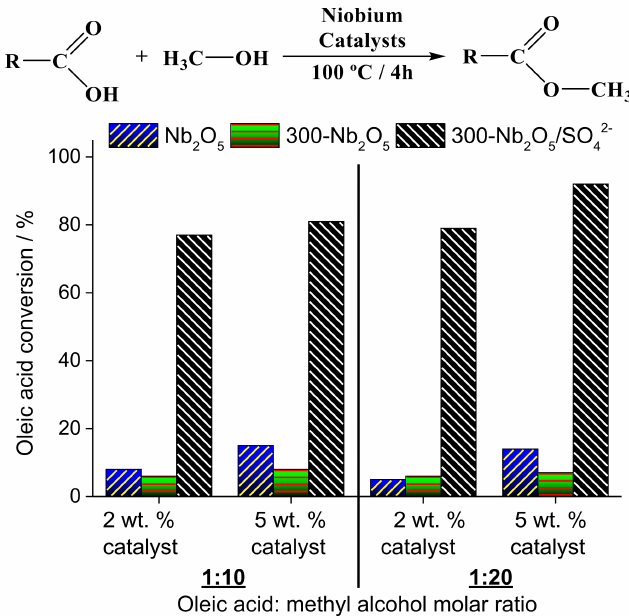
Figure 11. Esterification reaction of oleic acid with methyl alcohol over Niobium catalysts. Reaction conditions: oleic acid: methyl alcohol molar ratio (1:10 and 1:20), catalyst (2 and 5 wt%), temperature (100 ◦ C), time (4 h) (adapted from